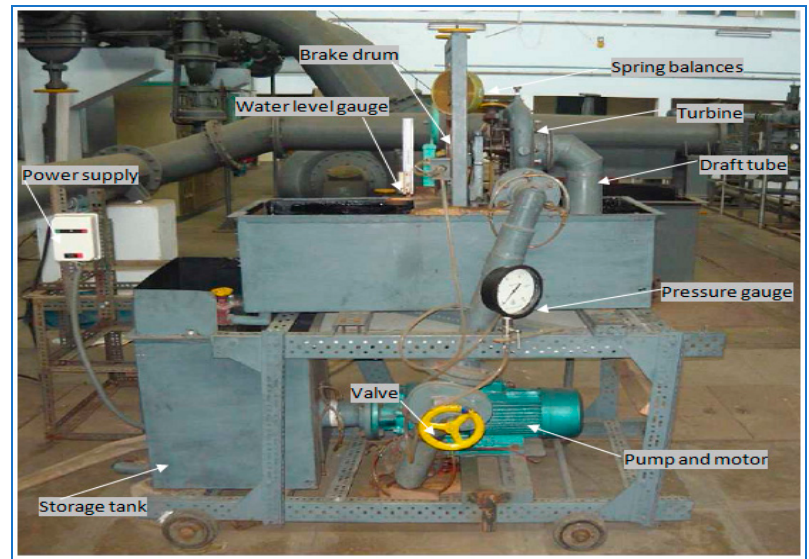
Figure 1. The Francis turbine test setup.